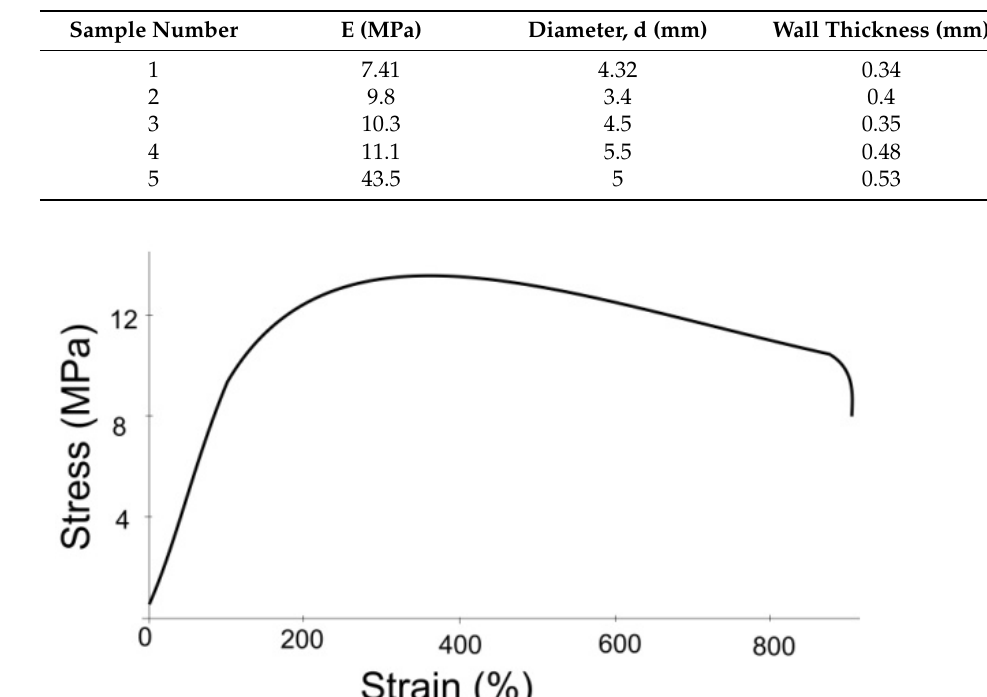
Figure 4. Plot of change in ultimate strength with specimen diameter.